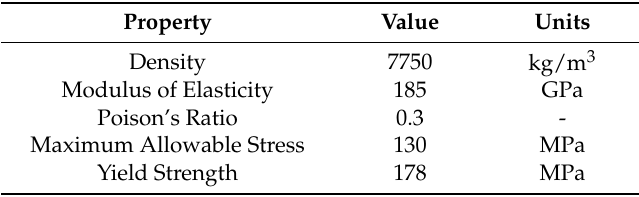
Table 1. Shaftline material properties.